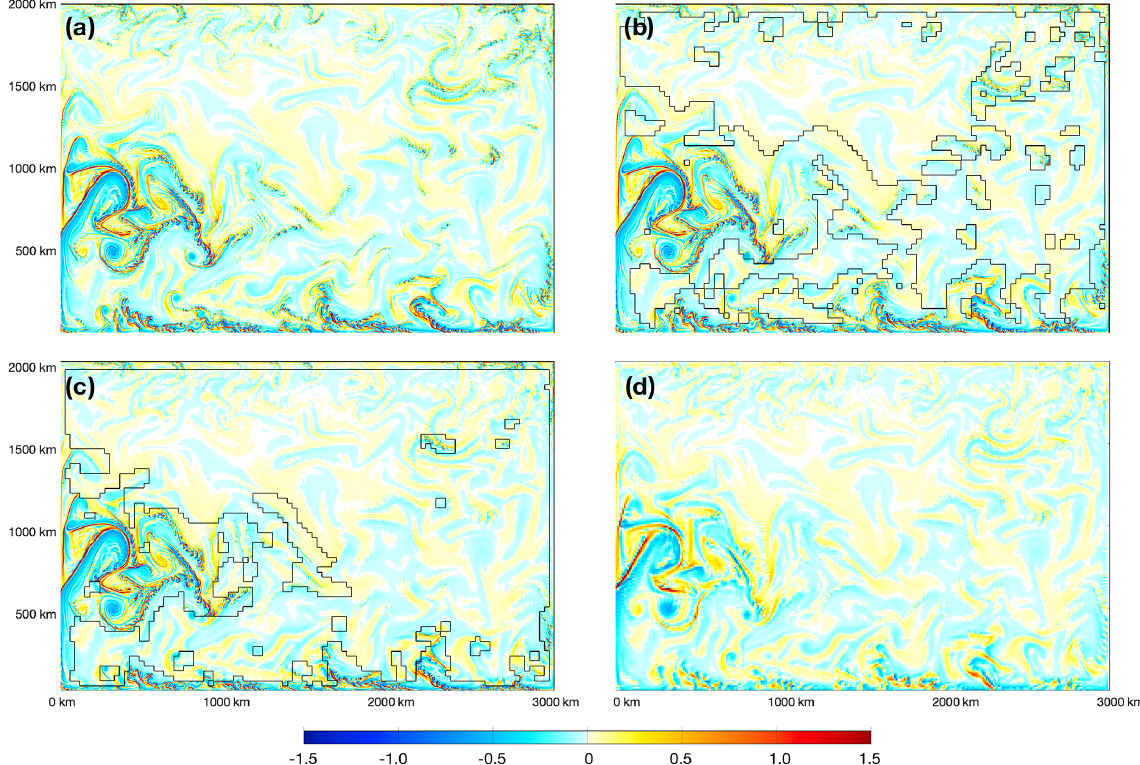
Figure 10. Surface Rossby number ( ζ/f ) after 5d of (adaptive) refinement from 0.1 to 0.02 ◦ since 1 February. Panels (a) , (b) , and (c) shows the result for the full-field 0.02 ◦ experiment (i.e., S), that of AMR setting 1 (i.e., M-S-I), and that of AMR setting 2 (i.e., M-S-II), respectively. In both AMR experiments (b, c) , the boundary between 0.02 and 0.1 ◦ is marked by black lines. Panel (d) shows the reference simulation result at 0.01 ◦ on the same